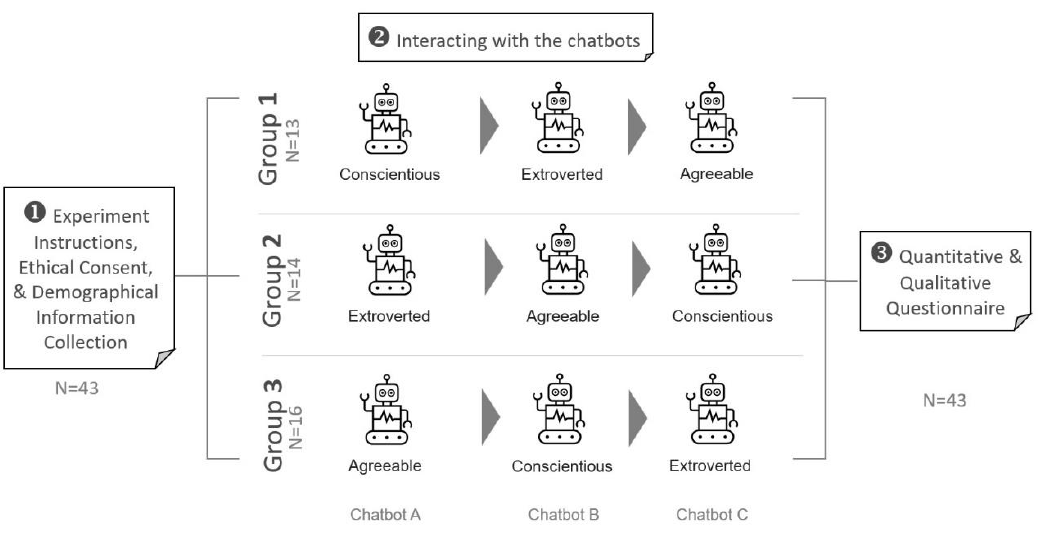
Figure 3. The steps of the study.